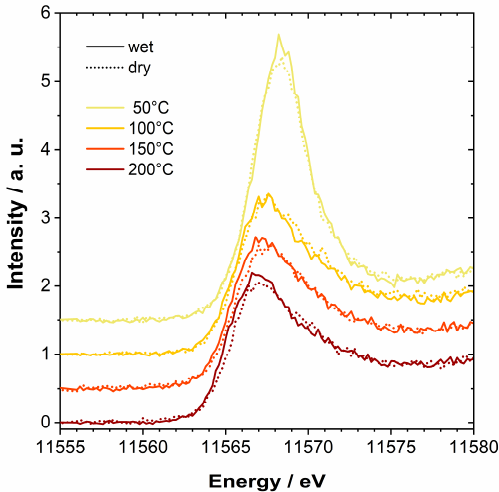
Figure 7. HERFD-XANES spectra recorded during CO temperature programmed reduction (1000 ppp Co/He), in absence (dotted lines) or presence (solid lines of water in the gas feed (H 2 O < 6%).